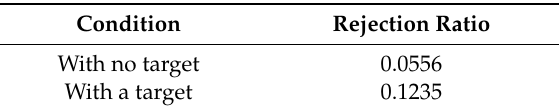
Table 1. Rejection ratios under di ff erent